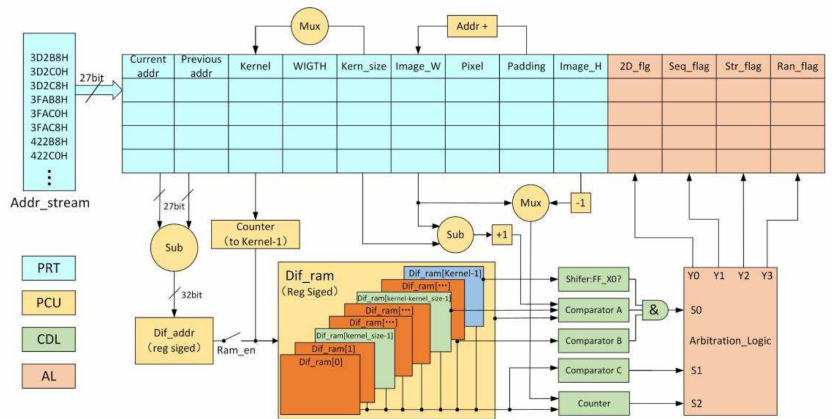
Figure 6. The proposed basic framework of stream access prediction